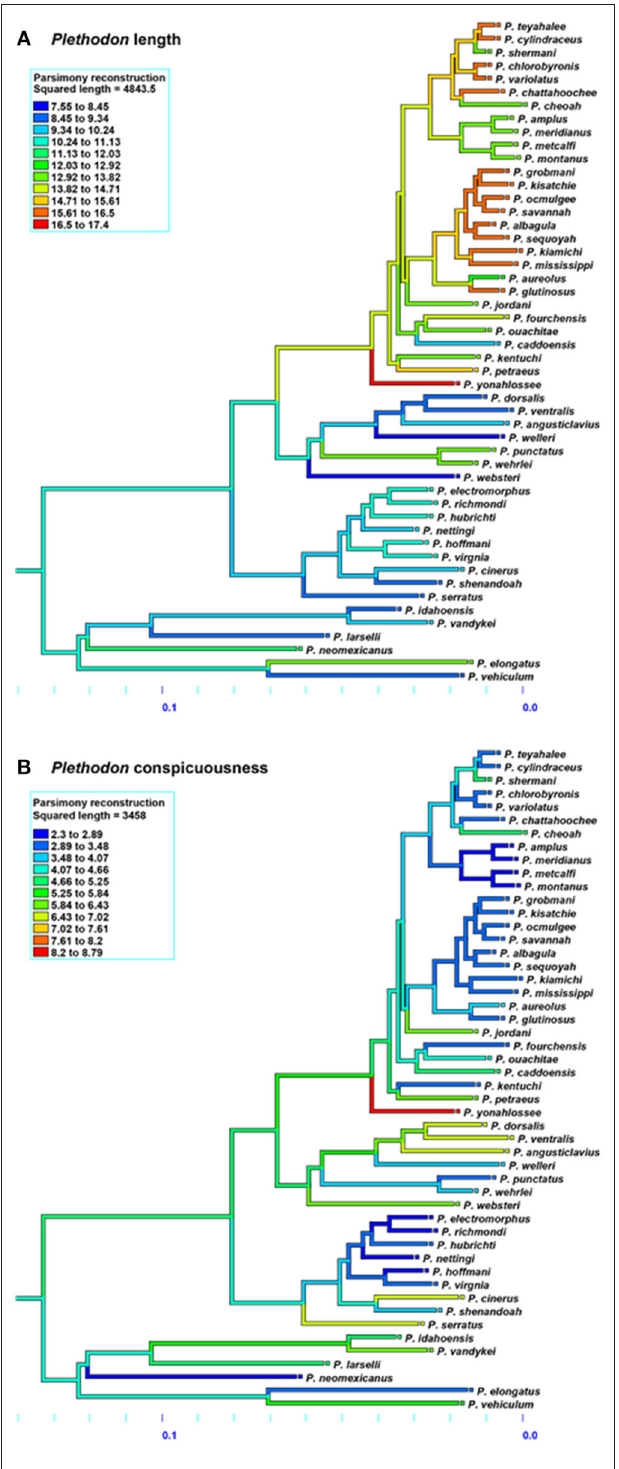
FIGURE 4 | Evolution of (A) average total length and (B) conspicuous coloration in Plethodon salamanders using the squared-change parsimony (Mesquite version 2.75). Orange and red shades represent a larger body size (top) and more conspicuous coloration (bottom). Phylogeny adapted from Wiens et al.